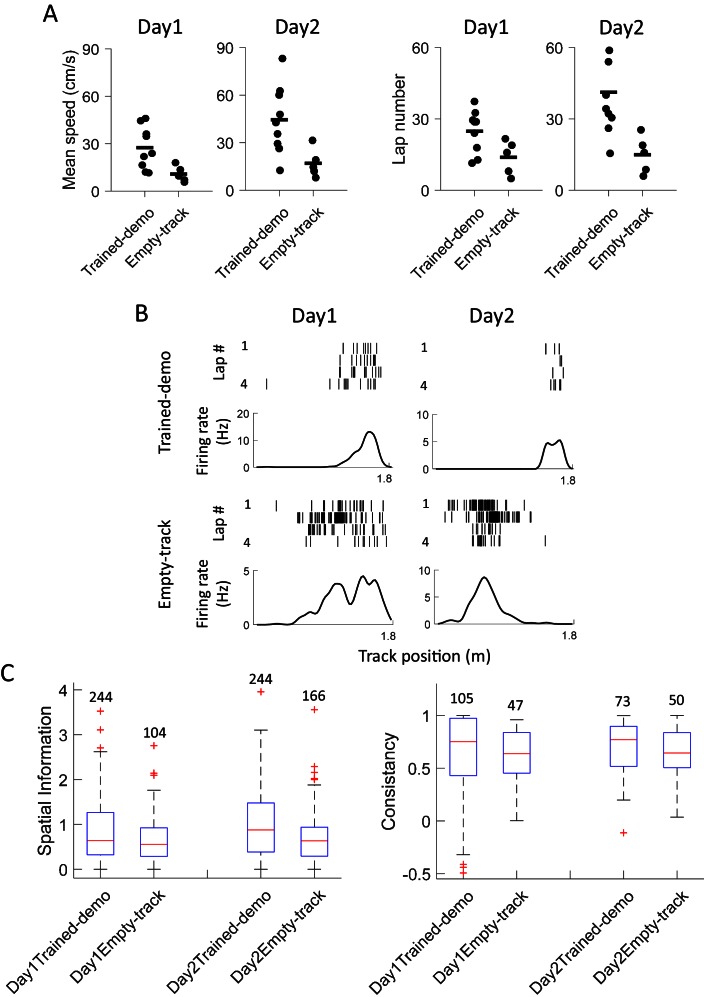
Experience in the box improved behavioral performance and novel place field development on the track.(A) Mean running speed and number of laps per trajectory in Track sessions of first two days (Day1, Day2) for the Trained-demo (N = 9) and Empty-track (N = 5) rats. Both parameters were significantly different between Day1 and Day2 (mean speed: F1,27 = 5.3, p=0.03; number of laps: F1,27 = 4.6, p=0.04; Two-way ANOVA). Trained-demo had significantly faster mean speed (F1,27 = 14, p=0.001) and ran more number of laps (F1,27 = 12, p=0.002). (B) Example place cells from a Trained-demo and an Empty-track rat on Day1 and Day2. For each condition and each day, a cell’s spike raster (top) and its firing rate curve (bottom: mean rate versus position) during the first 4 laps of a trajectory are shown. Each tick is a spike. (C) Spatial information for all active cells under each condition (Trained-demo, Empty-track) on each day (Day1, Day2). Number on top of each bar: number of cells. There was a significant main effect between the conditions (F1,791 = 21, p=0, Two-way ANOVA), but not between days (F1,791 = 1.4, p=0.25). (D) Same as C, but for lap consistency. Although median values of lap consistent in Trained-demo appeared to be higher than those in Empty-track, there was no significant main effect between the conditions (F1,274 = 0.11, p=0.74, Two-way ANOVA) or between days (F1,274 = 1.8, p=0.17).